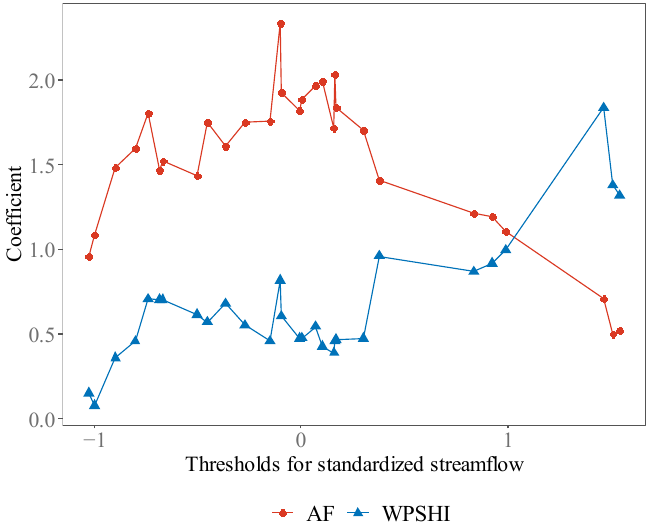
Figure 9. Coefficients of the logistic regression model forecasting summer streamflow of Hankou and Datong based on WPSHI(R) and antecedent streamflow (AF). The coefficients are the averaged values of models for all testing years.